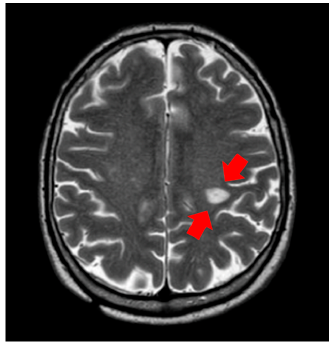
Figure 2. Second brain magnetic resonance imaging performed after discontinuation of sunitinib and steroid